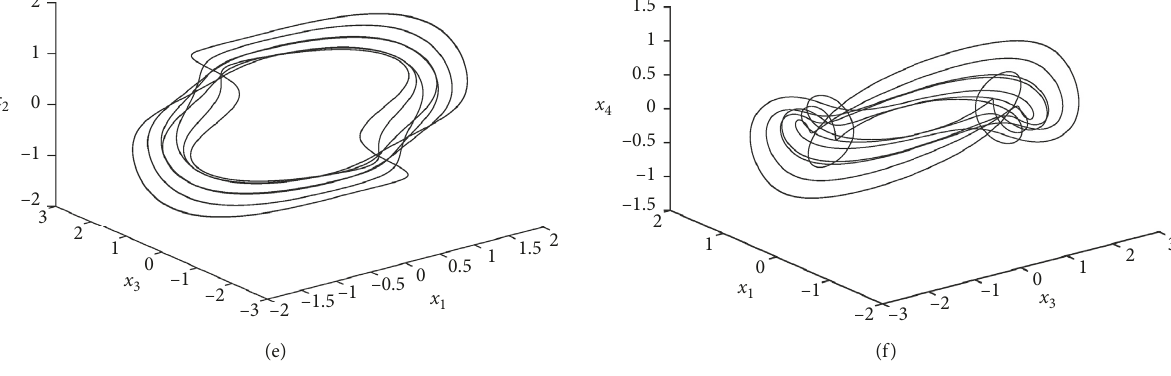
Figure 15: Periodic-7 motion occurs when b